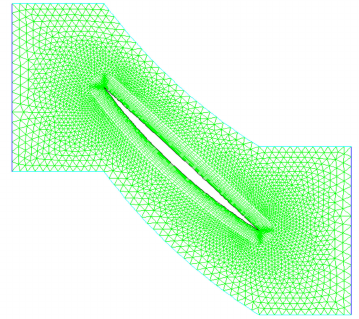
Figure 25. Grid used for the numerical solution.